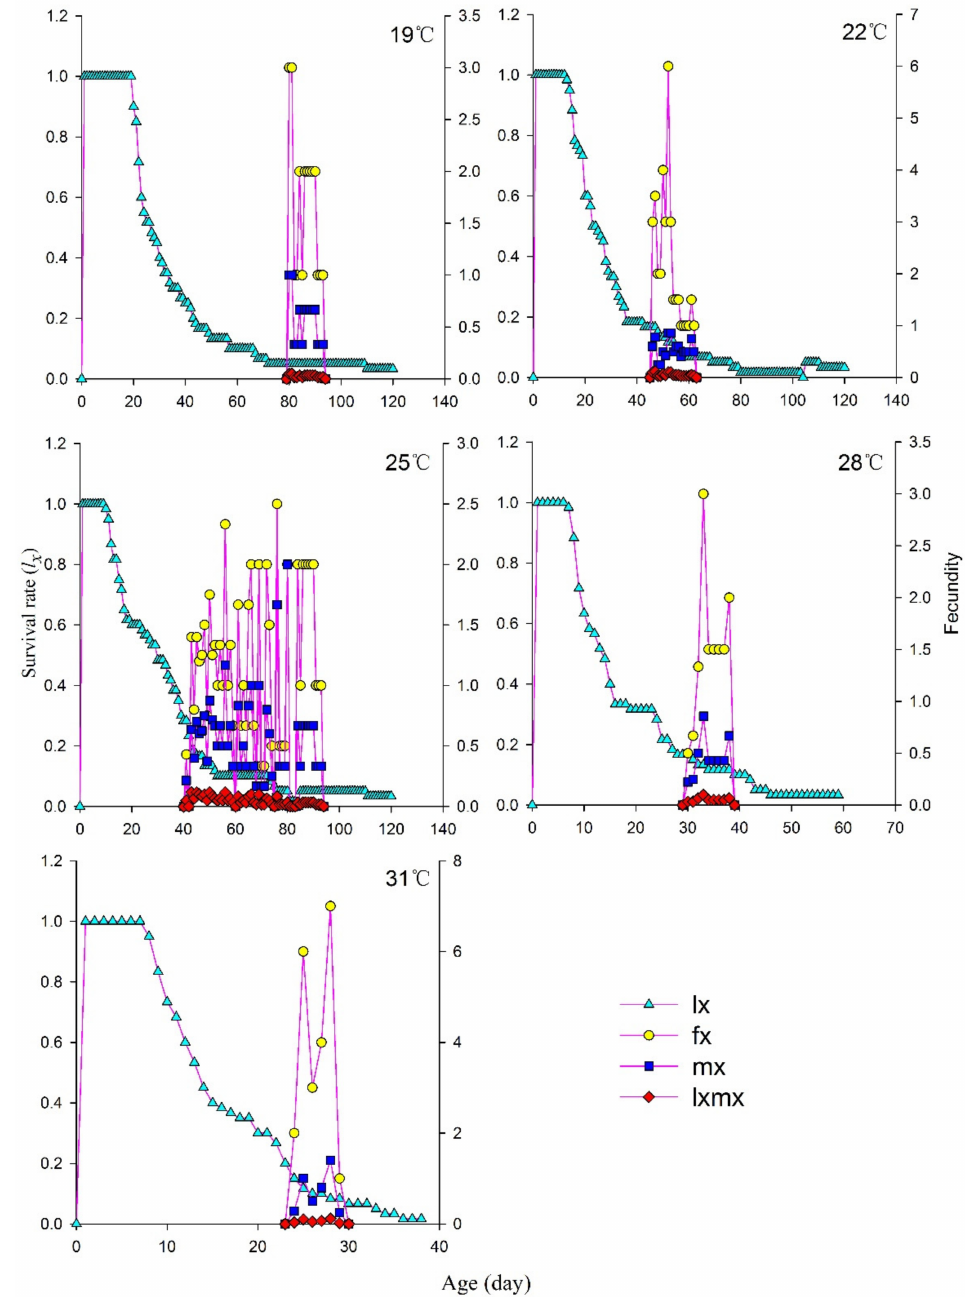
Figure 3. Age-specific survival ( lx ), age–stage-specific fecundity ( fx ), age-specific fecundity ( m x ), and age-specific maternity ( l x m x ) of Riptortus pedestris at different